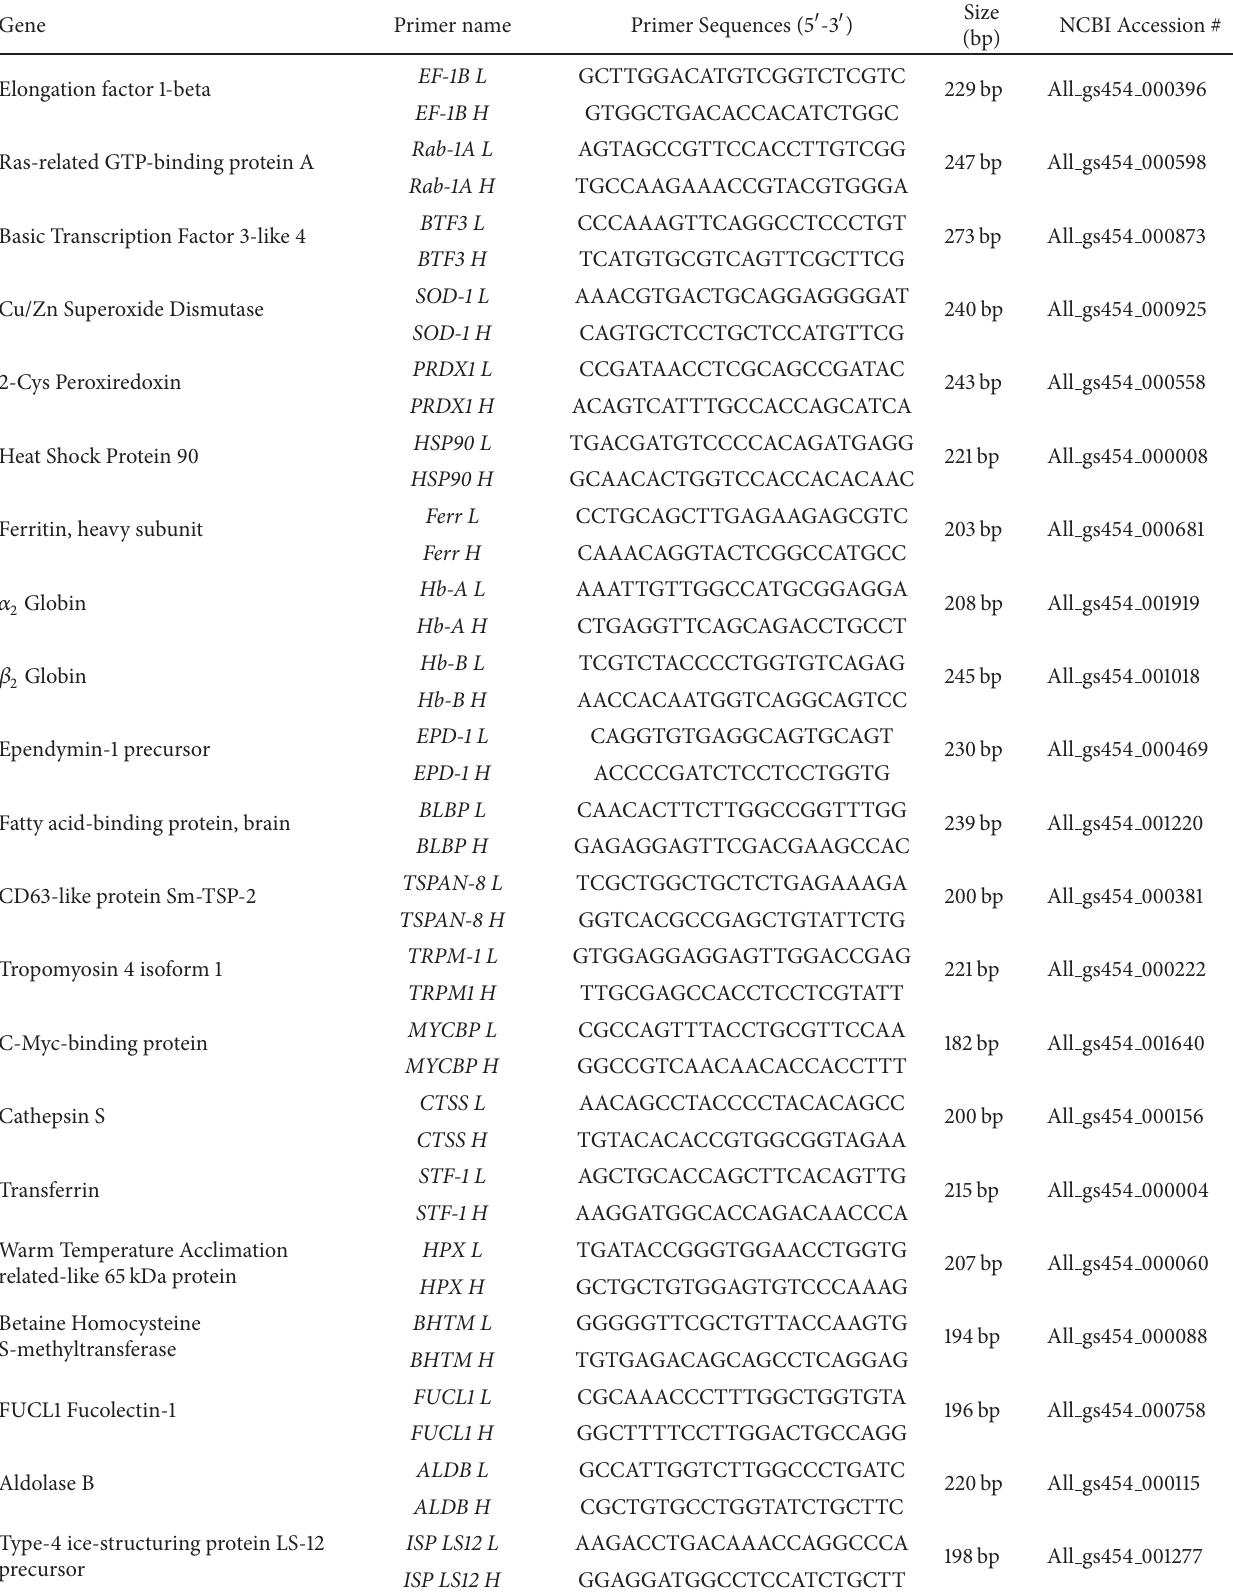
Table 1: List of targeted genes using qPCR, primer sets specifically designed for this study, size for each of the product, and NCBI accession number for all the EST